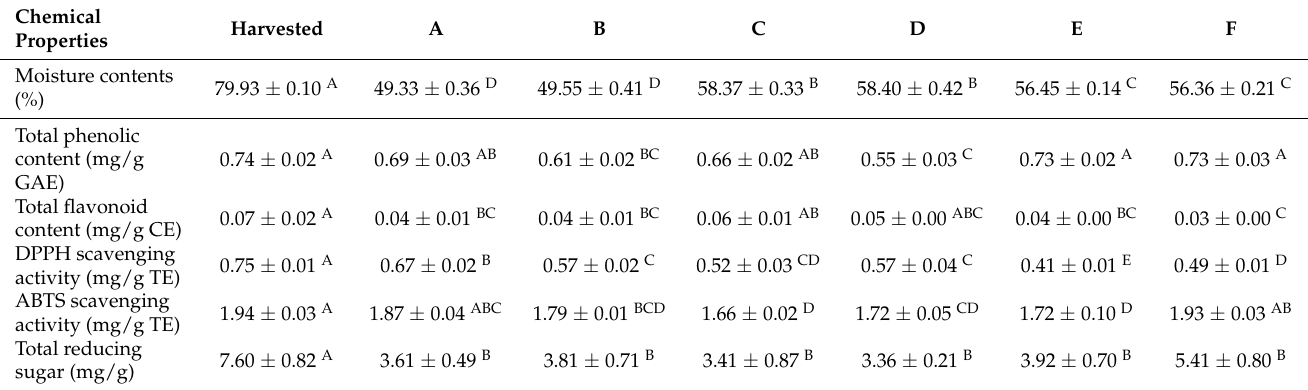
Table 2. Chemical properties of garlic material after treatment with various postharvest